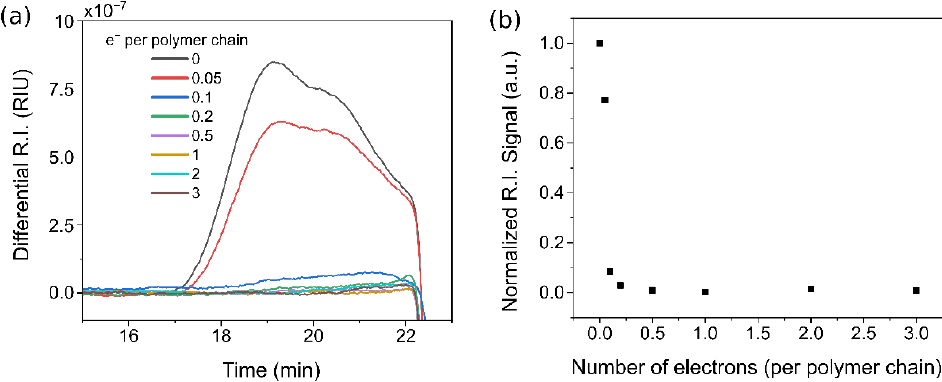
Figure 3. ( a ) SEC elugrams of electrolyzed solution of pDTT in 0.1 M Bu 4 NBF 4 /DMF after consump- tion of a specified amount of charge expressed as the number of electrons consumed per polymer chain. ( b ) Normalized integral of pDTT SEC elugrams (16.5 – 22.2 min) vs. the number of electrons consumed relative to the same integral recorded before electrolysis.